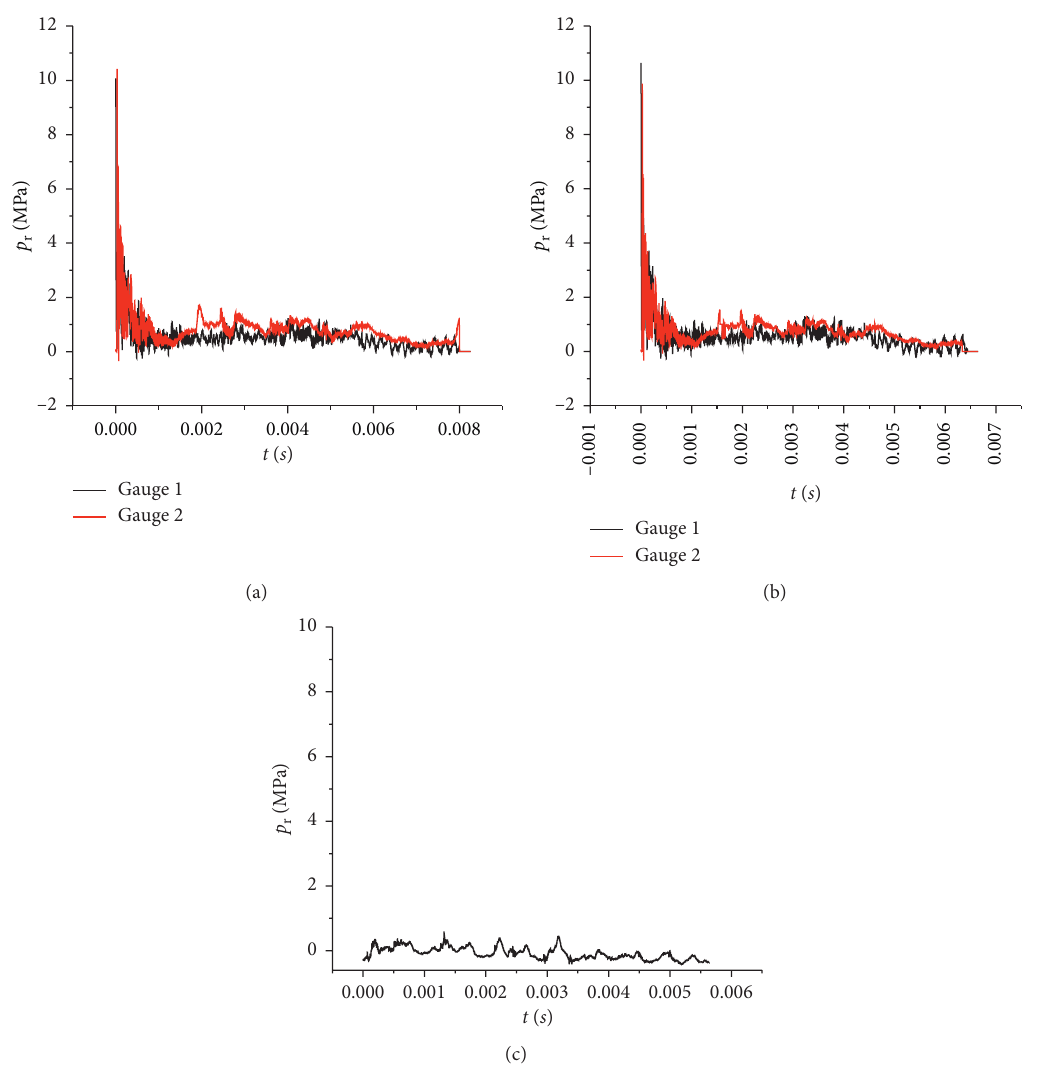
Figure 3: Shock wave load p-t curve. (a) Simulated chamber 1. (b) Simulated chamber 2, upper level. (c) Simulated chamber 2, lower level.